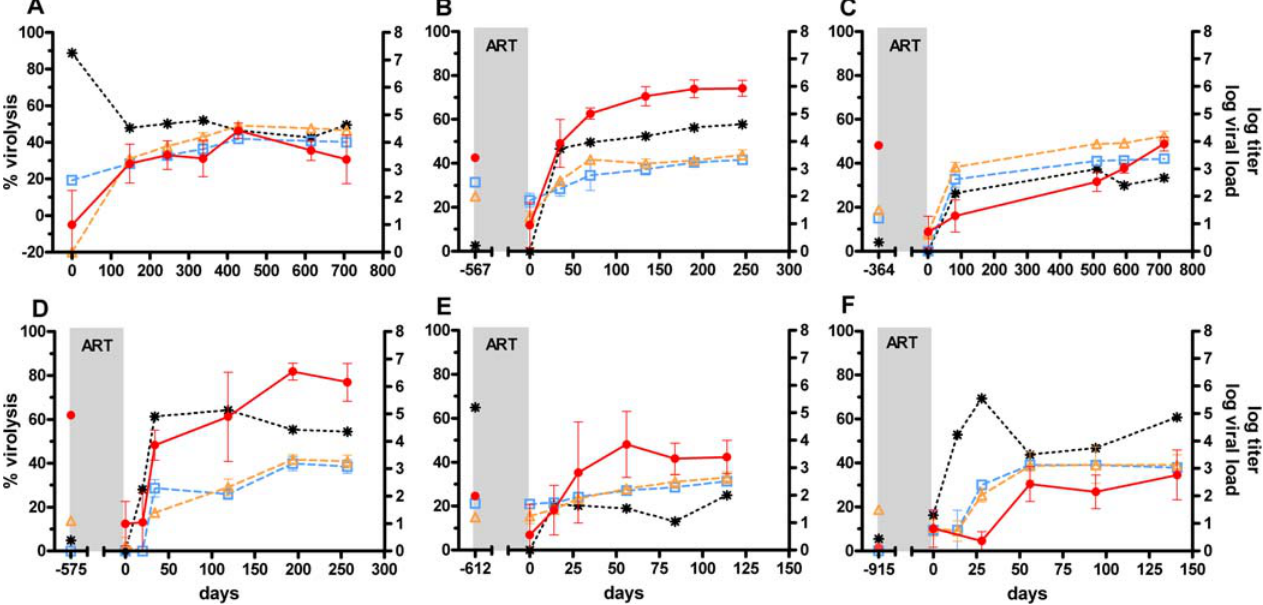
Figure 5. Longitudinal Assessment of Autologous Complement Lysis Activity in Patient Plasma Lysis activity against autologous virus (red circles) of plasma from six acutely HIV-1-infected patients was measured longitudinally and plotted against anti-gp120 titers (orange triangles), anti-gp41 titers (blue squares), and viral load (asterisks). At the first data point, patients were treatment-naı¨ve and acutely HIV infected. All patients (except patient 022) subsequently went on antiretroviral therapy for the indicated time periods. Time point 0 was assigned to the date of treatment interruption and the remaining time points were calculated according to this time point. (A) Patient 022 (treatment- naı¨ve), (B) patient 015, (C) patient 003, (D) patient 016, (E) patient 026, and (F) patient 002. doi:10.1371/journal.pmed.0030441.g005 PLoS Medicine |